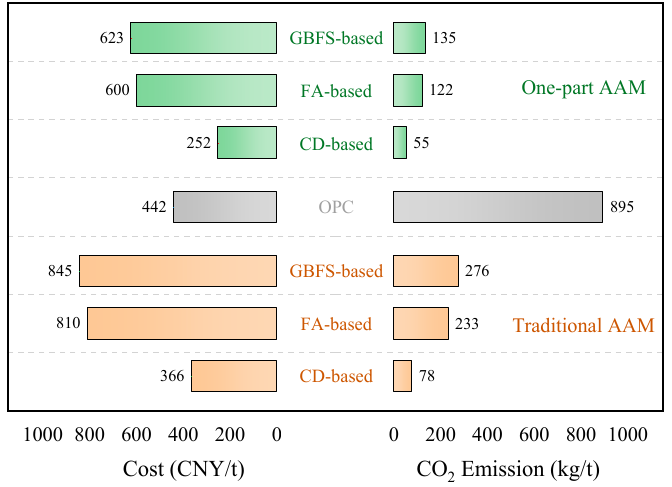
Figure 2. Cost and carbon footprint of AAM and OPC